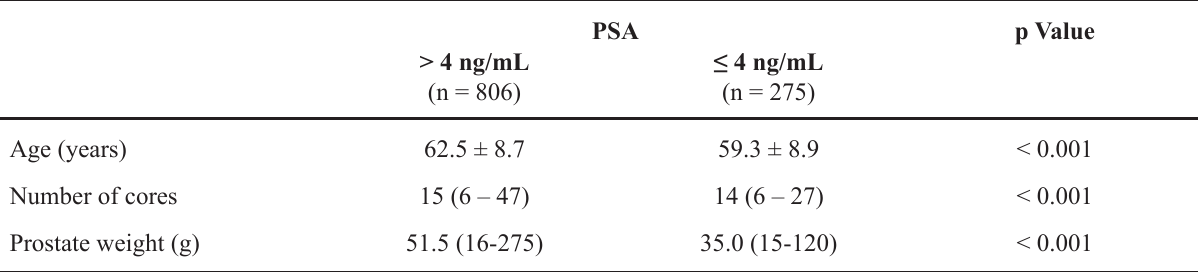
Table 1 – Characteristics of 1081 patients submitted to prostate biopsy between January 2005 and October 2006 consid- ering the PSA level.